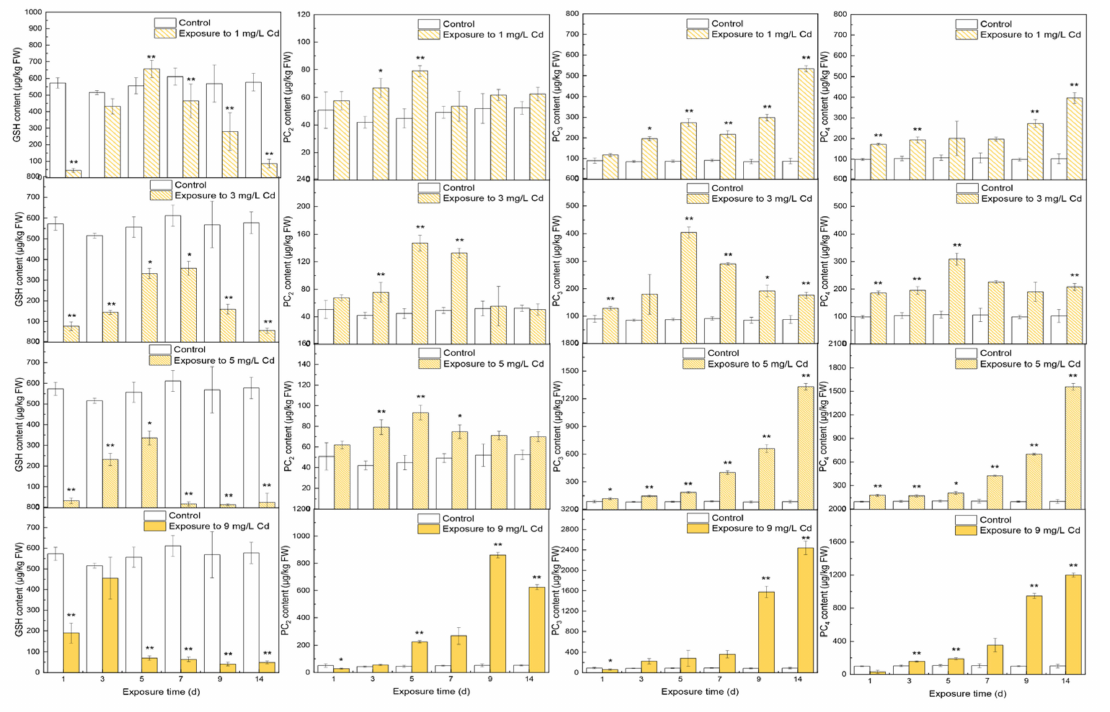
Figure 1. The contents of thiols in roots under different levels of Cd stress. All values represent the means ± SD of three replicates. Stars indicate significant differences from the control (**: p < 0.01, *: p < 0.05).